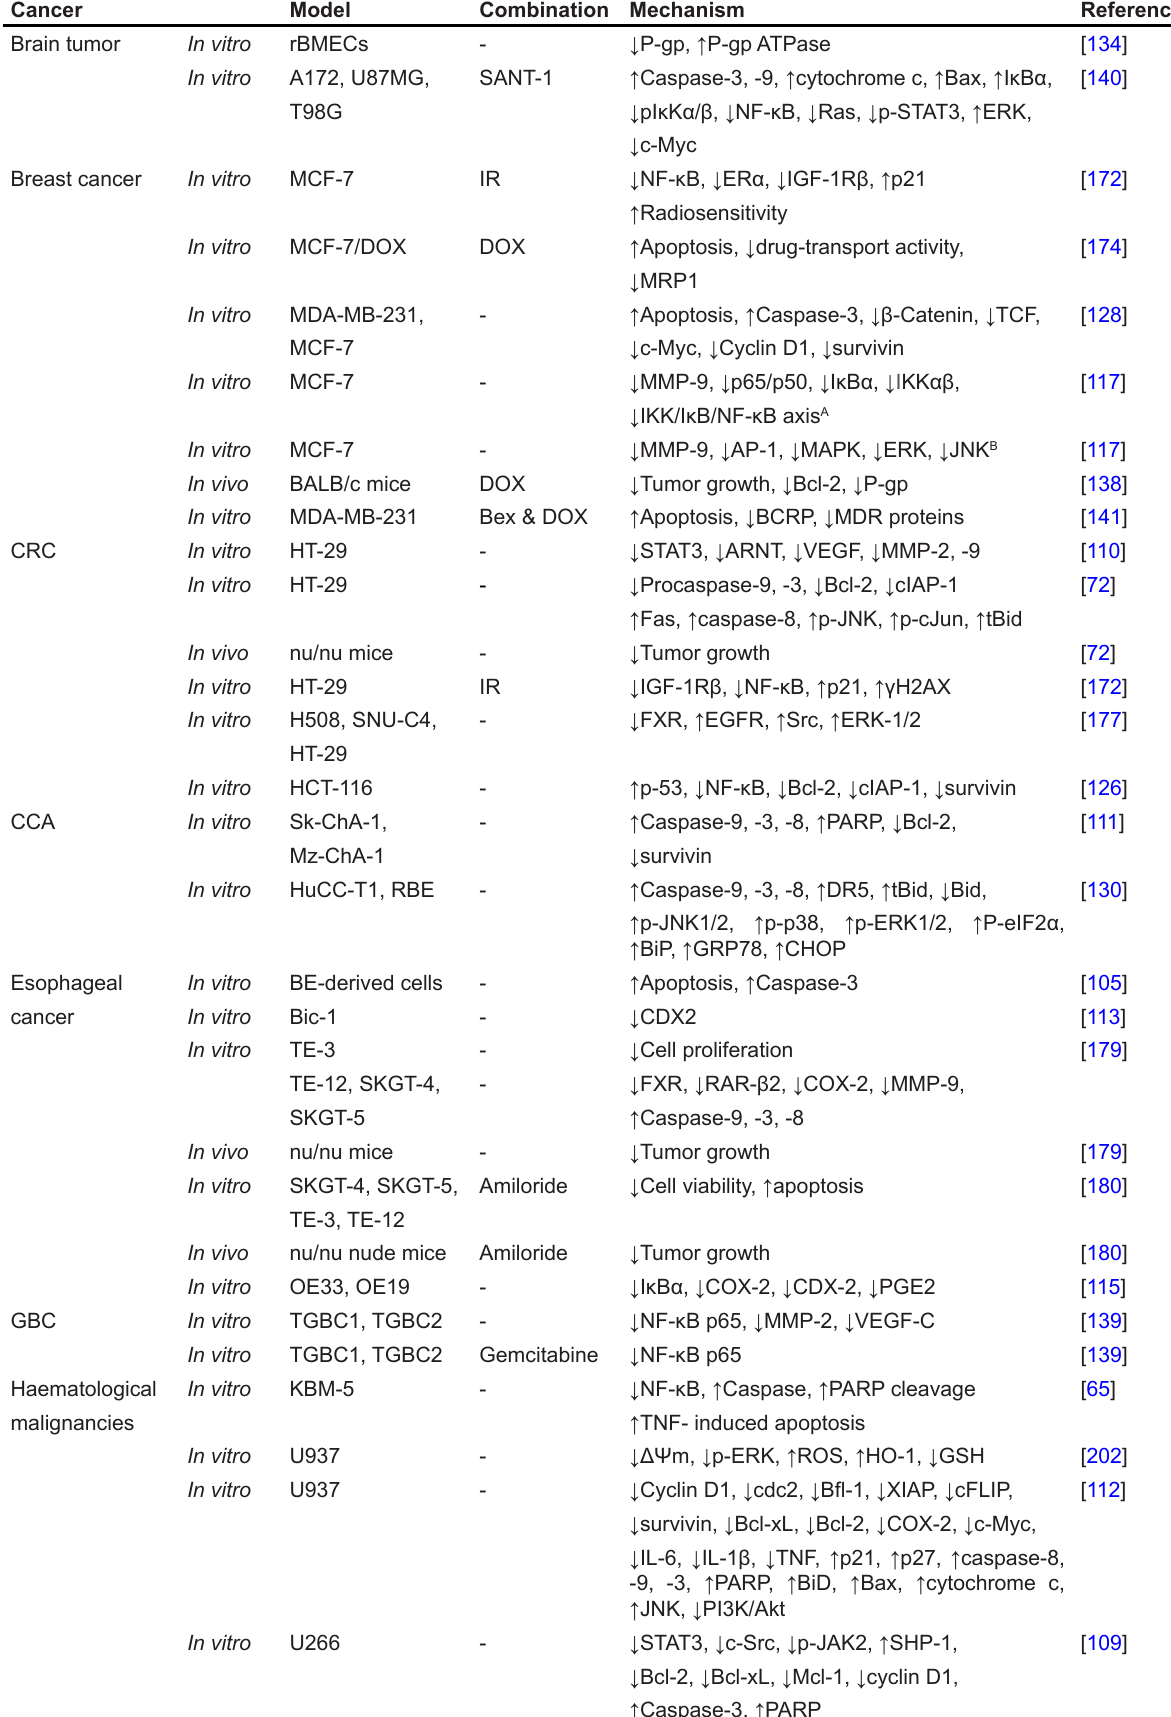
Table 1. Potential of GS and its derivatives in the prevention and treatment of cancer Cancer Model Combination Mechanism Brain